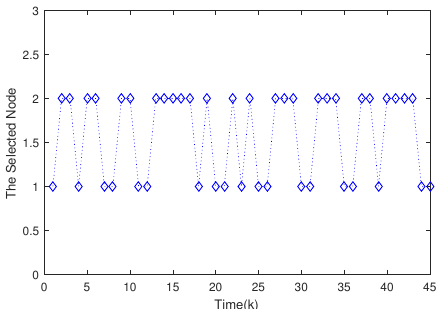
Figure 8. The evolutions of selected node under the RAP scheduling